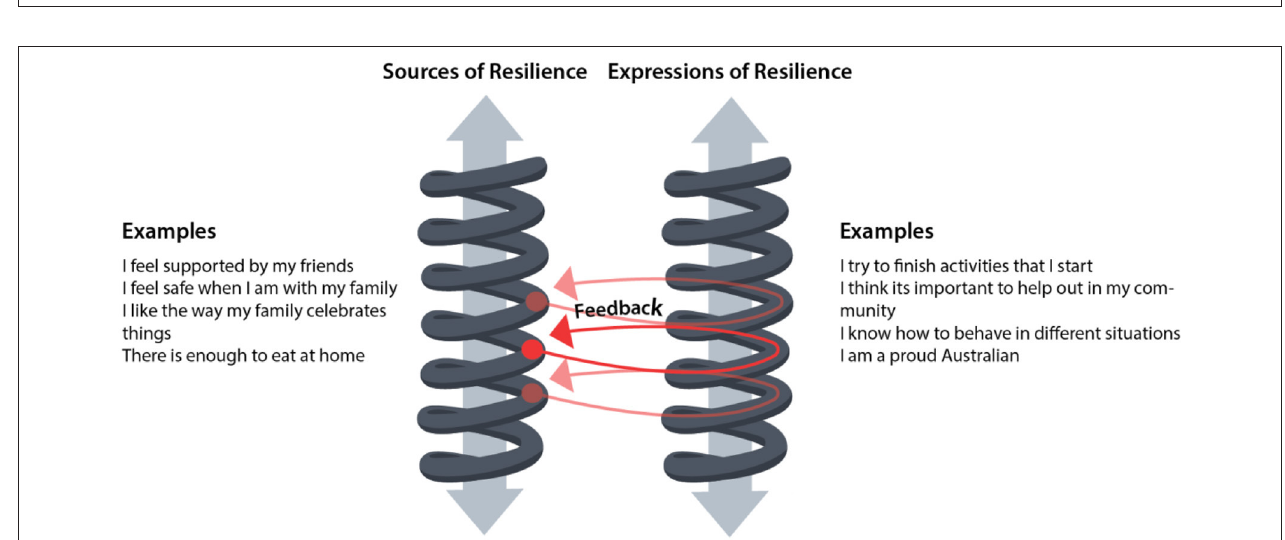
FIGURE 3 | Hypothesized dynamic interaction of sources and expressions of resilience.